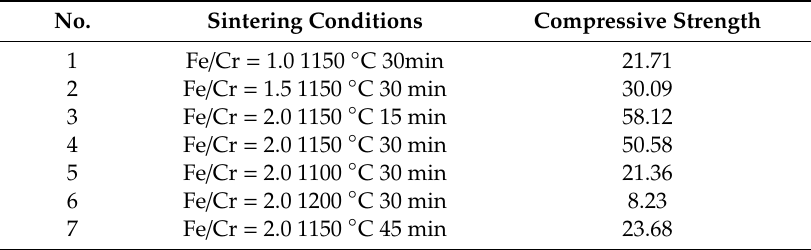
Table 3. Compressive strength of ceramic tile at different sintering conditions (MPa). No.